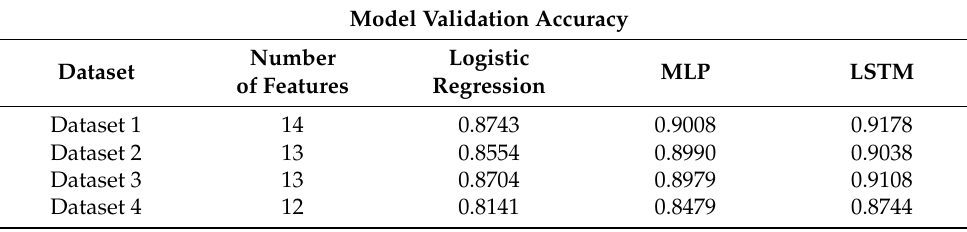
Table 2. Validation accuracy values (with perfect = 1.00) across the four datasets considered, as described in Section 4.5.1